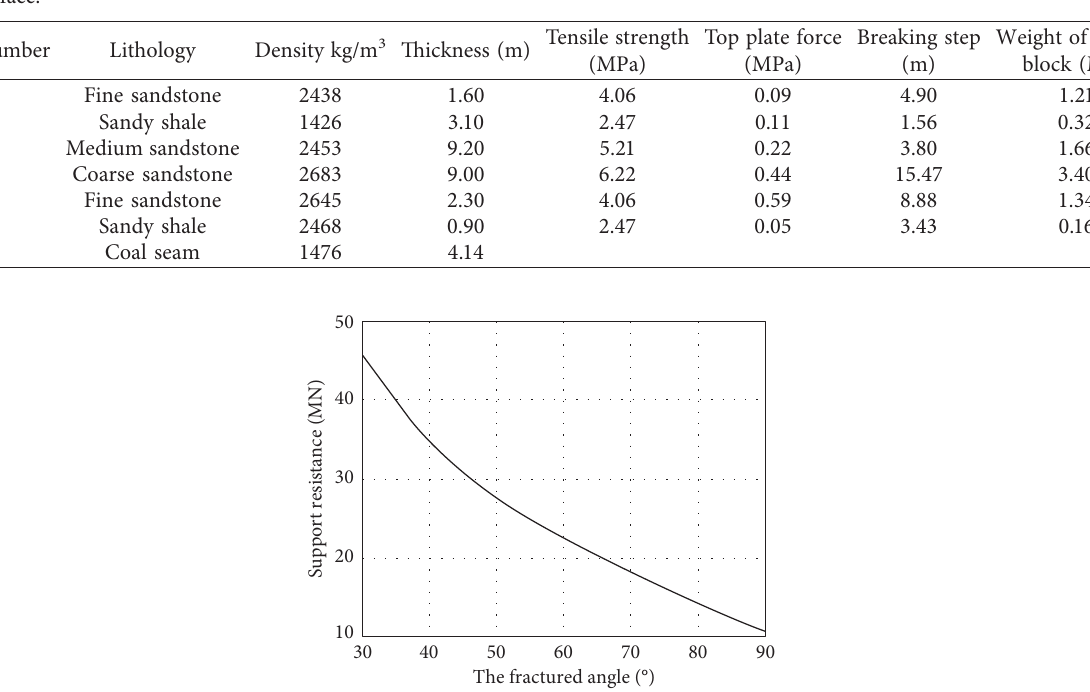
Table 4: The physical and mechanical characteristics of the roof combination of cantilever structure of No. 8218 large mining height working face.